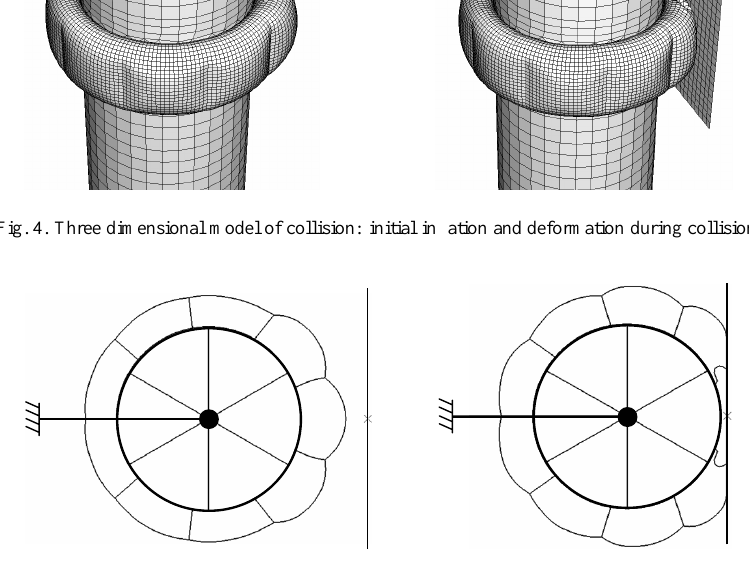
Fig. 5. Two dimensional model of collision: initial state and resulting